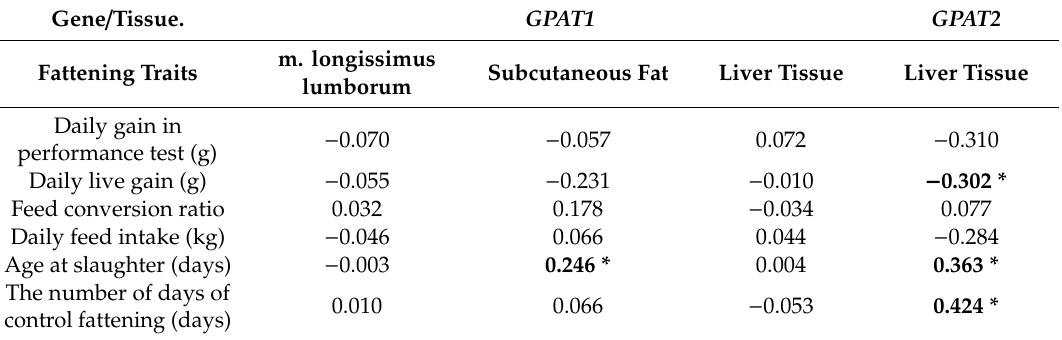
Table 5. Correlation between the expression level of the GPAT1 gene in m. longissimus lumborum, subcutaneous fat, liver tissue and the expression level of GPAT2 gene in liver tissue with fattening traits (* p ≤ 0.05; ** p ≤